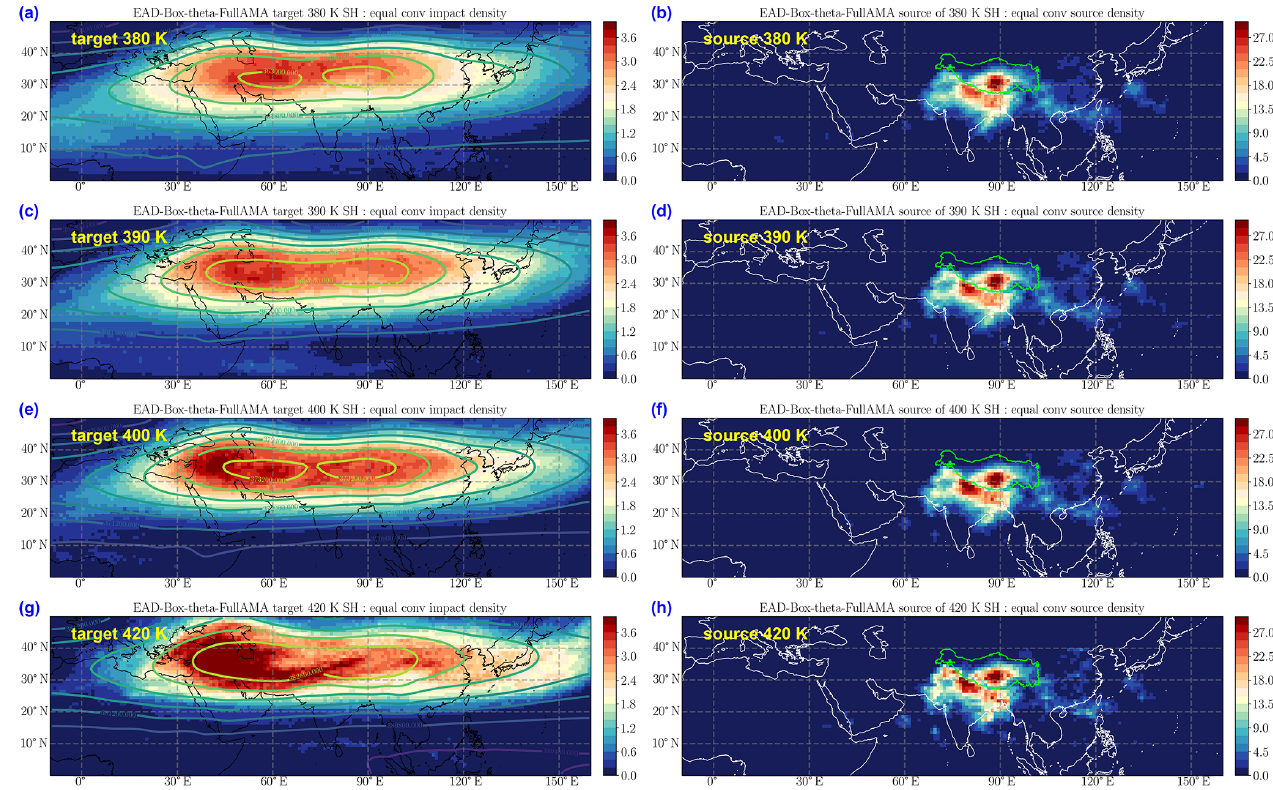
Figure 8. Same as Fig. 7 but for the levels (from top to bottom) 380, 390, 400 and